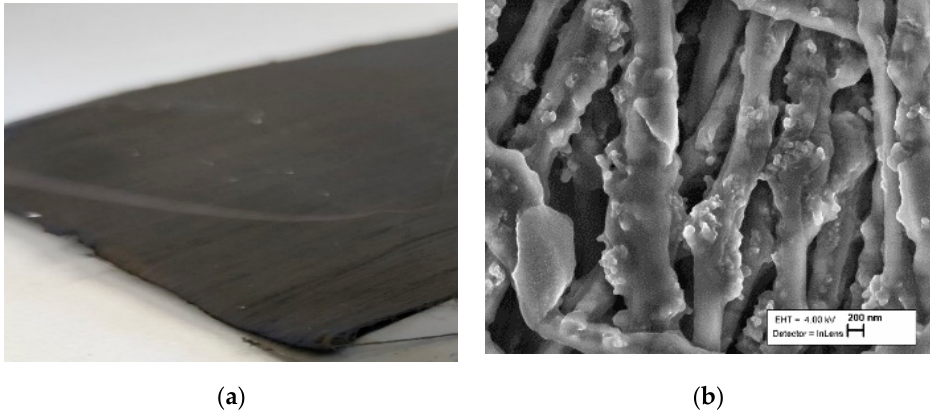
Figure 1. ( a ) Electrospun electrode 3 × 4 cm 2 sheet and ( b ) morphology of the fibres examined by SEM.